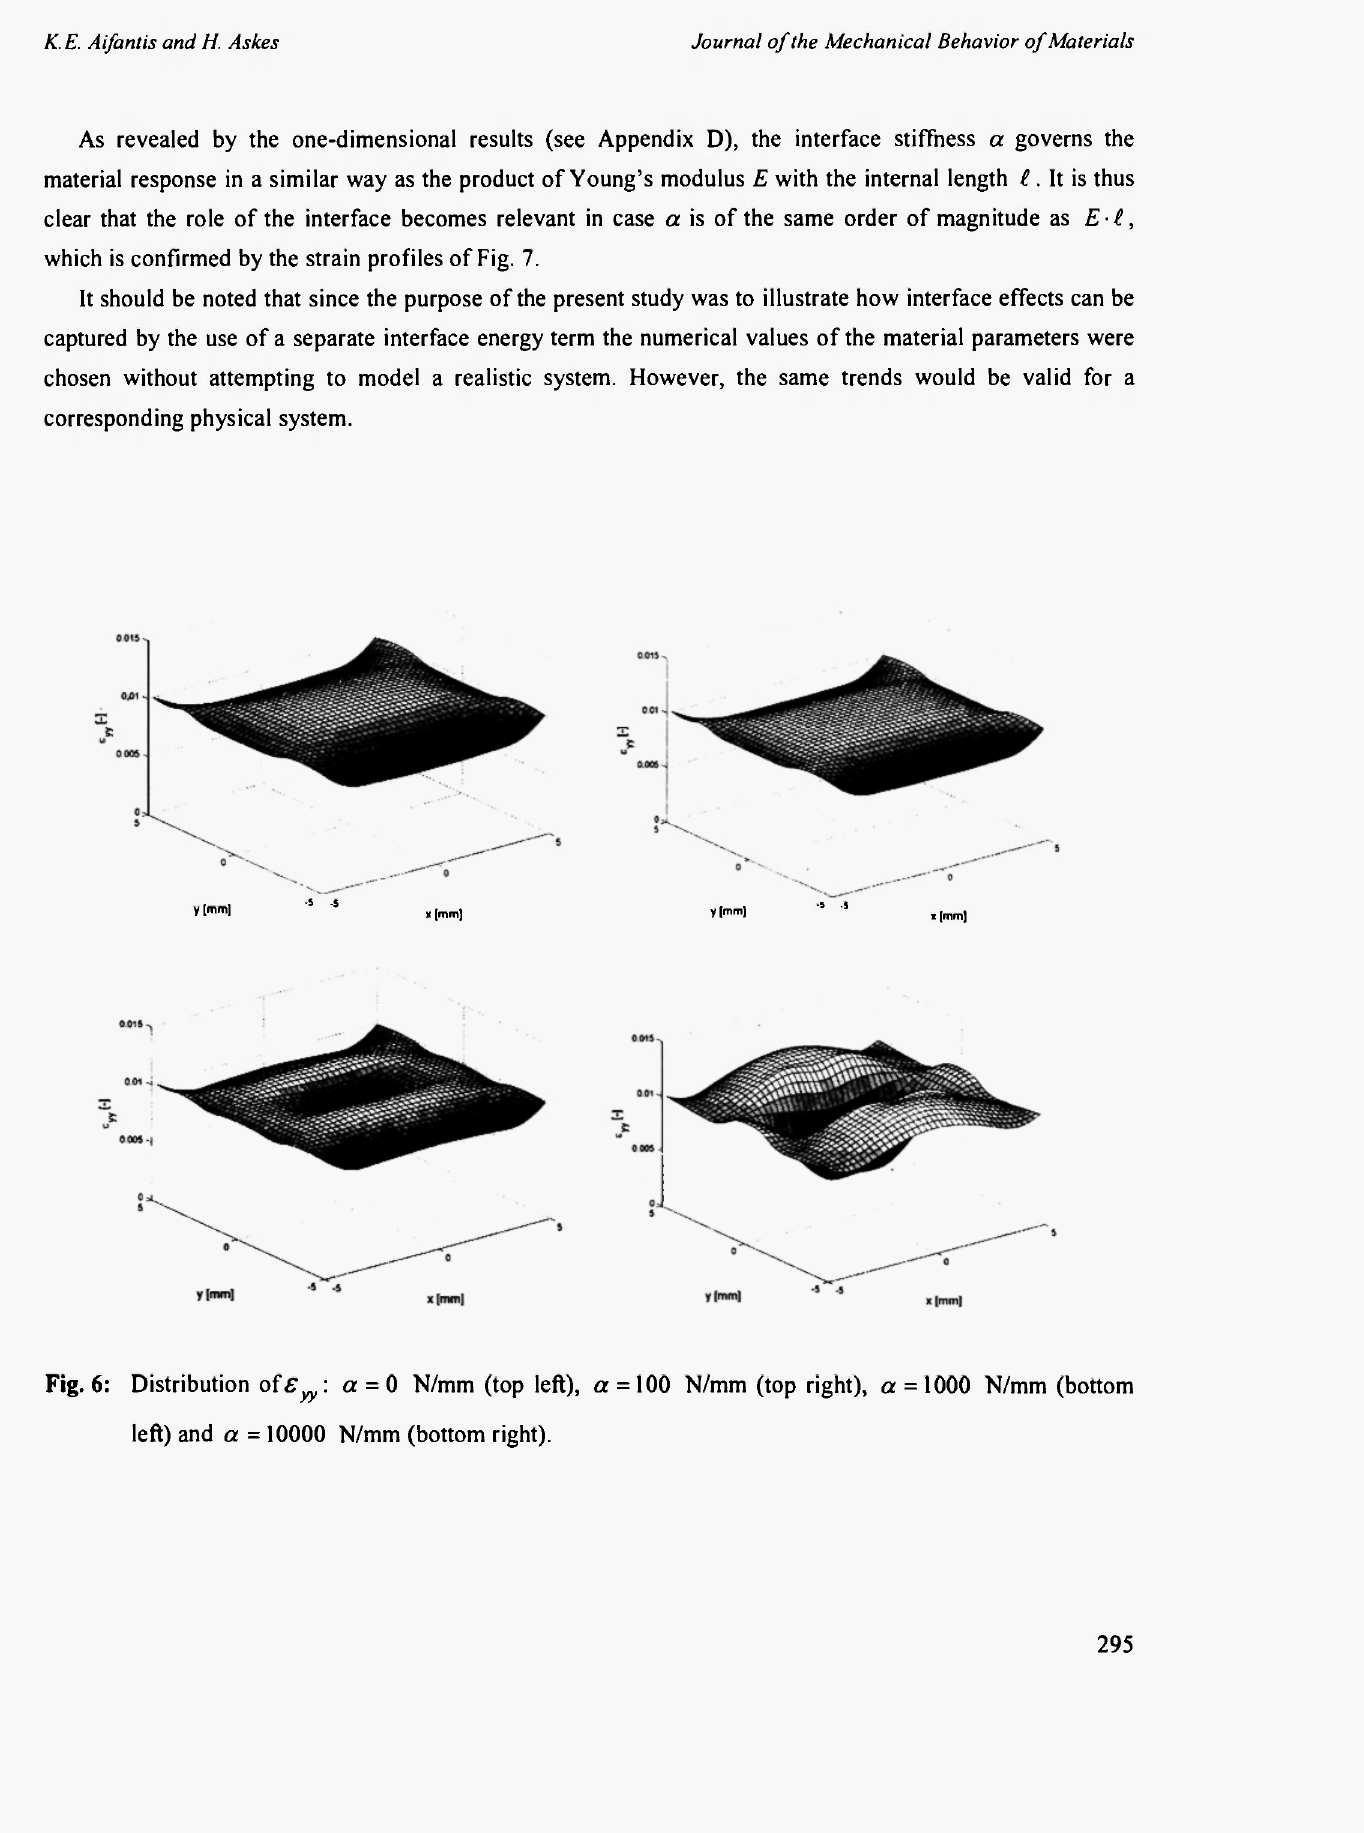
Fig. 6: Distribution of ε ^: a = 0 N/mm (top left), α = 100 N/mm (top right), a = 1000 N/mm (bottom left) and a = 10000 N/mm (bottom